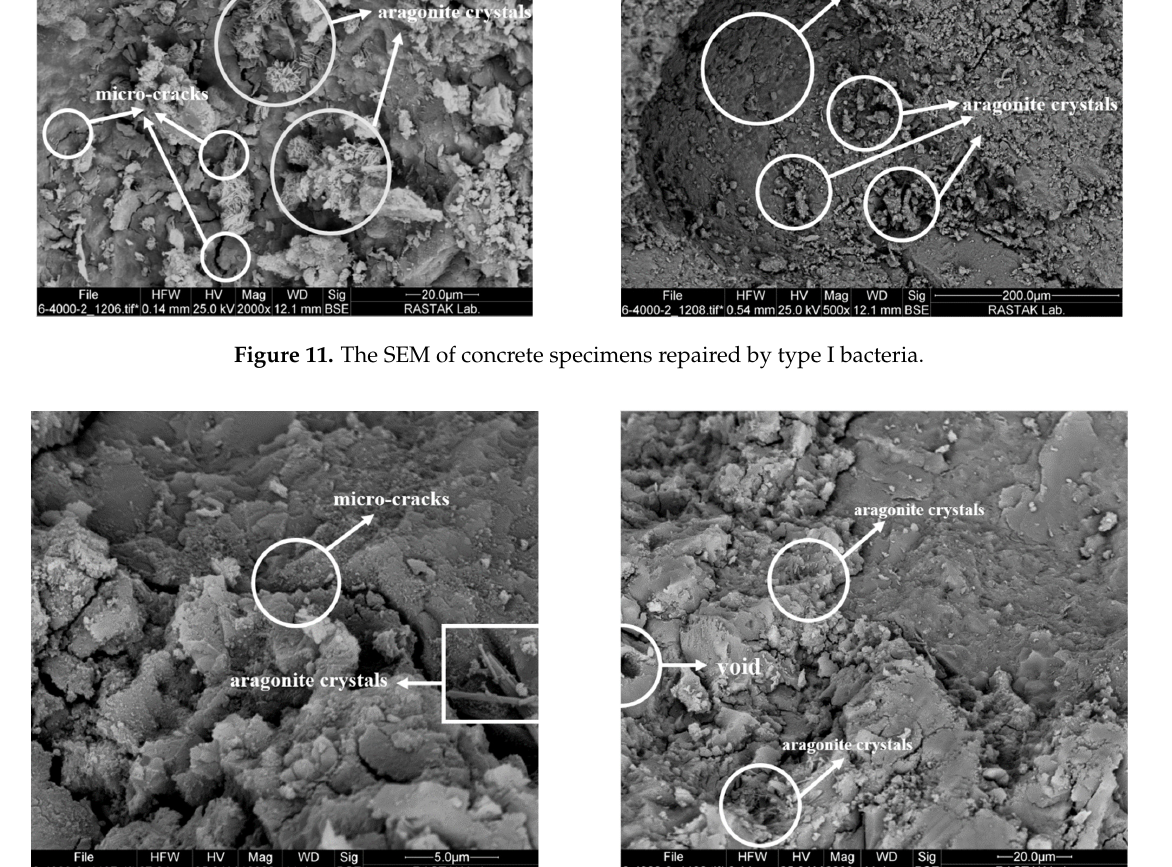
Table 6. The weight percentage of elements in concrete containing type I bacteria. Elements